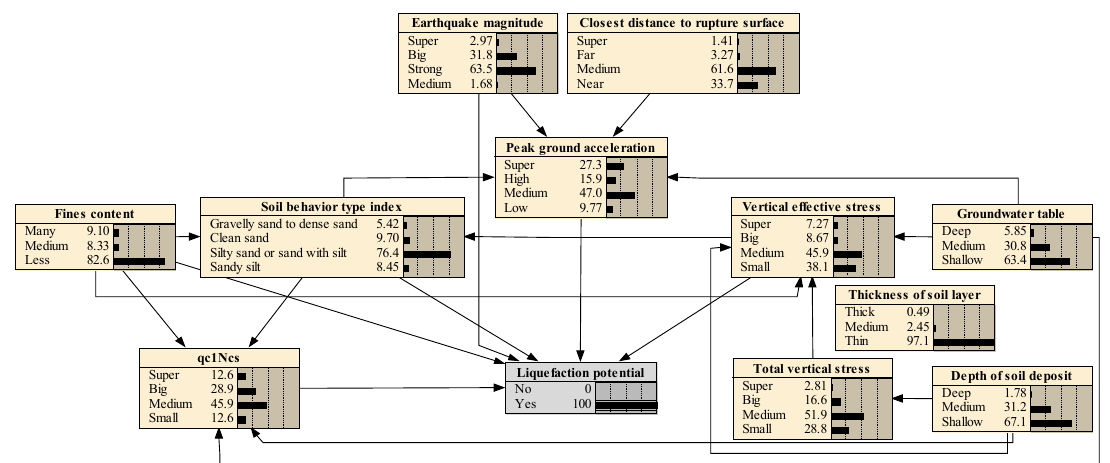
Figure 7. Posterior probability when the liquefaction potential evidence state is “yes.”